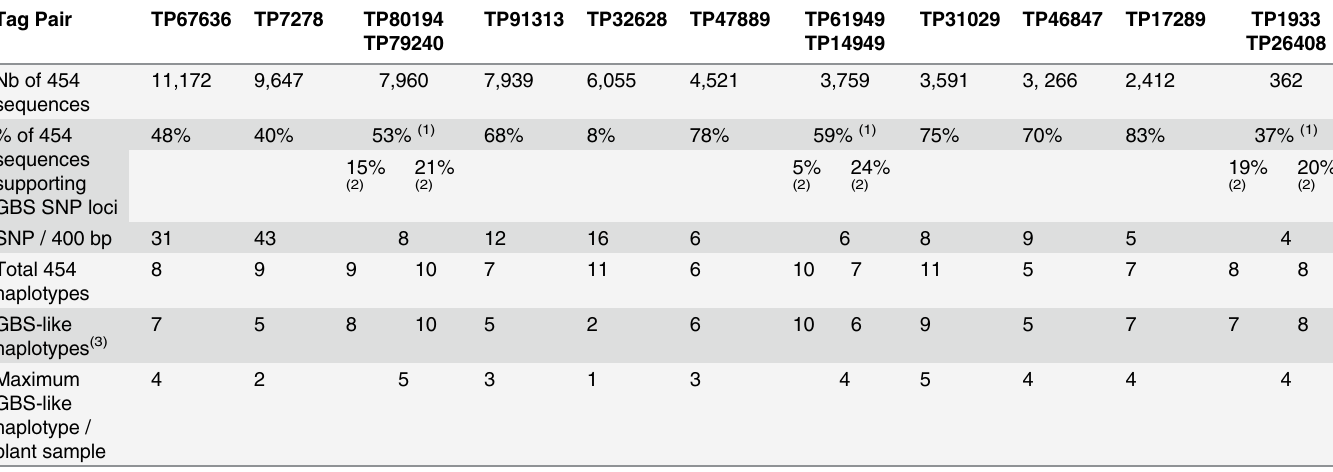
Table 5. Results of 454 sequencing of regions covering 14 SNP loci identified with